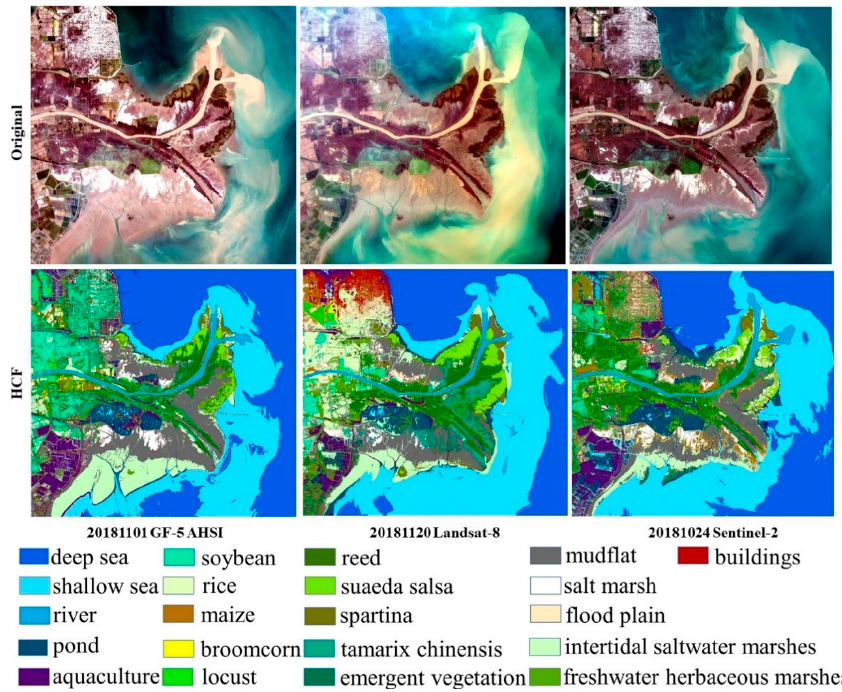
Figure 8. The comparison of 13 land cover types classification maps of Landsat-8, Sentinel-2 and GF-5 data. Remote Sens. 2019 , 11 , x FOR PEER REVIEW